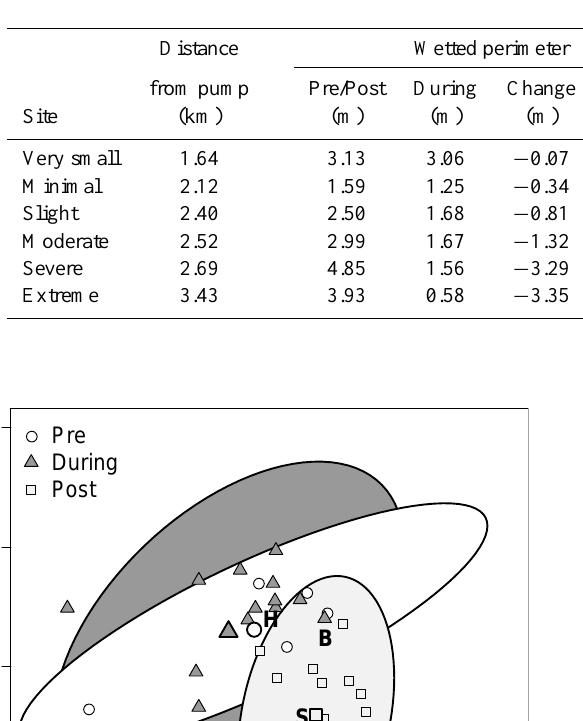
Table 1. Wetted perimeter and depth (analogues for aquatic habitat availability) by site pre/post- and during-dewatering. Distance from pump is the stream distance from a given site to the downstream pump that controlled the dewatering.